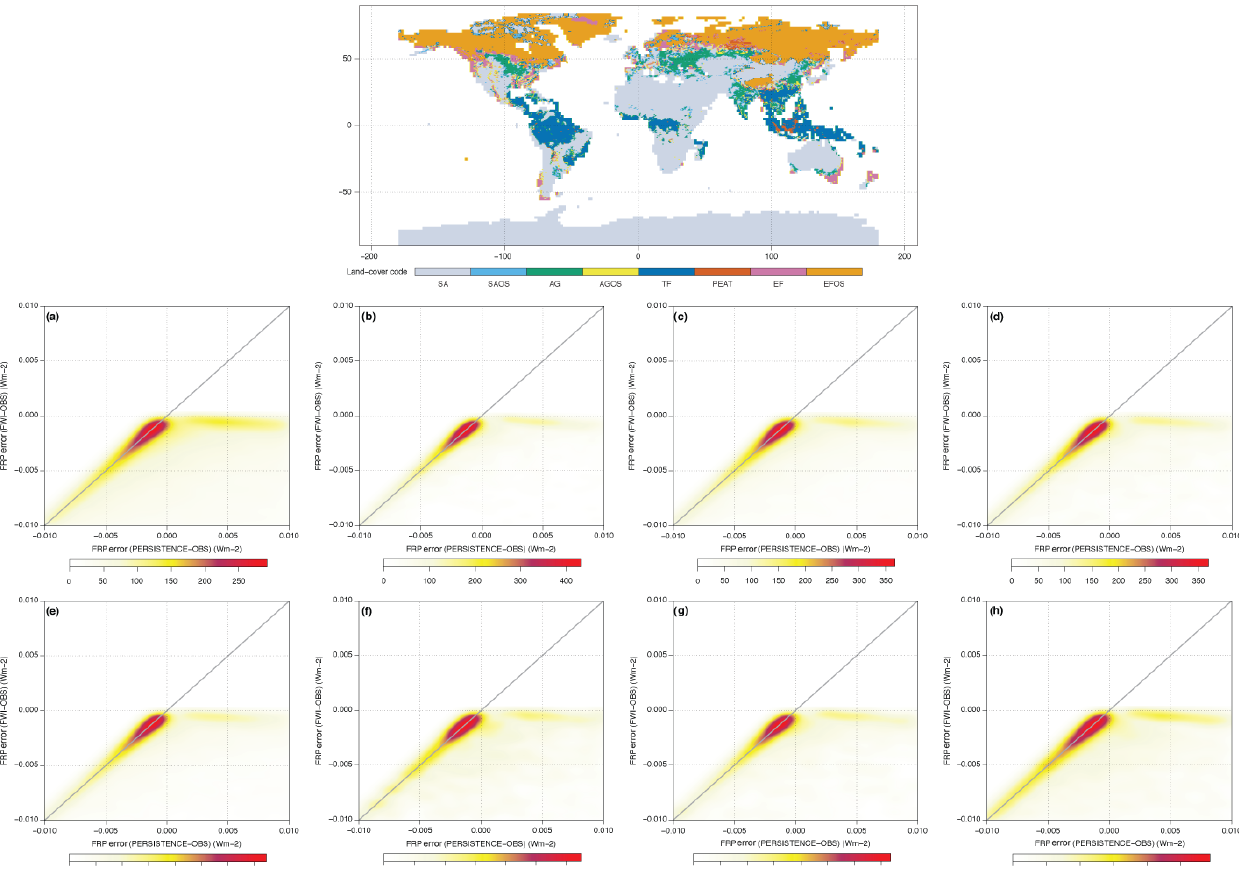
Figure 6. (a–d) Land cover class map based on dominant fire type in GFEDv3.1 and organic soil and peat maps. Gaps in land areas have been filled. See Kaiser et al. (2012) for details. (e–h) Two-dimensional probability density functions (PDFs) of the observed FRP departure of MODIS compared to the two observation operator models relying on the assumption of persistence and on the FWI. The PDF refers to different land covers: (a) savanna (SA), (b) savanna with organic soil (SAOS), (c) agriculture (AG), (d) agriculture with organic soil (AGOS), (e) tropical forest (TF), (f) peat (PEAT), (g) extratropical forest (EF), and (h) extratropical forest with organic soil